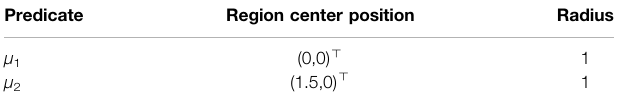
TABLE 2 | Geometric characteristics of regions of interest for an STL motion planning task. Predicate